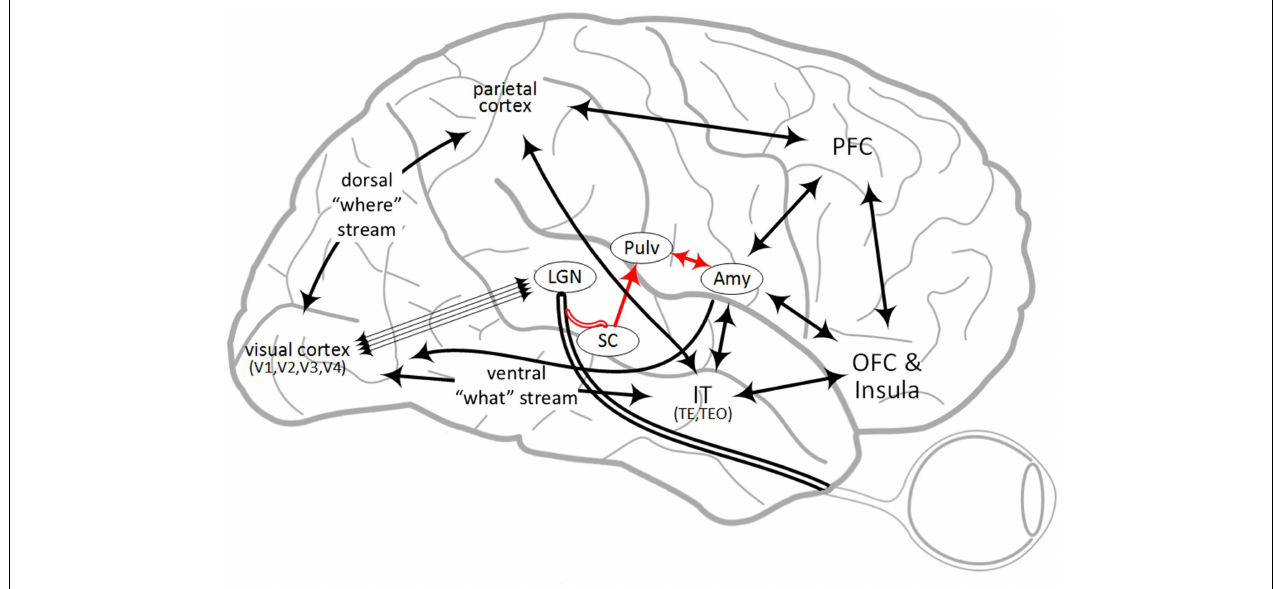
FIGURE 1 | Overview of some brain regions involved in fear processing and some of the connectivity between them. Abbreviations are described in Table 1 . The “low road” pathway is shown in